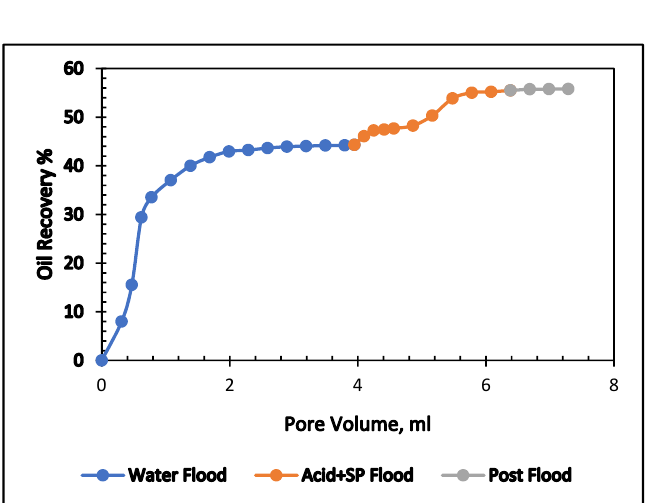
Figure 14. Total oil production from the carbonate core after brine, 0.4% Acrylic acid, and SP mixture, followed by a post-flood with brine.